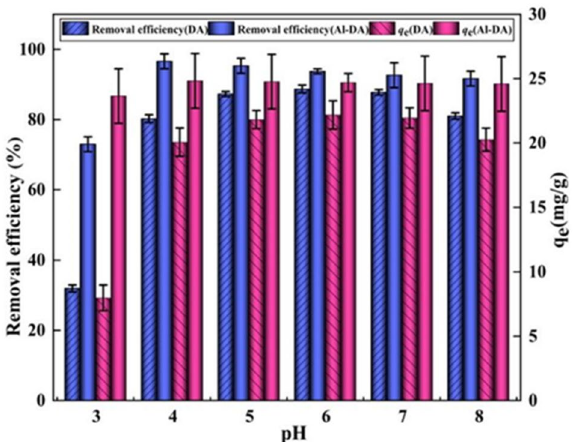
Figure 9. Effect of the pH on the adsorption of F − by DA and Al-DA (fluoride initial concentration is 100 mg/L, Sorbent dose 4 g/L, contact time is 2